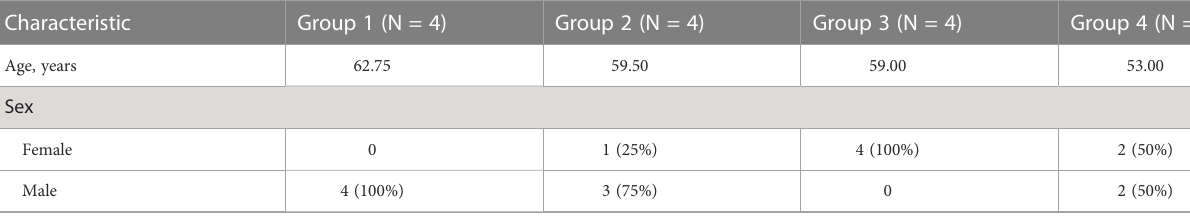
TABLE 2 Patient ’ characteristics and clinical presentations after omicron